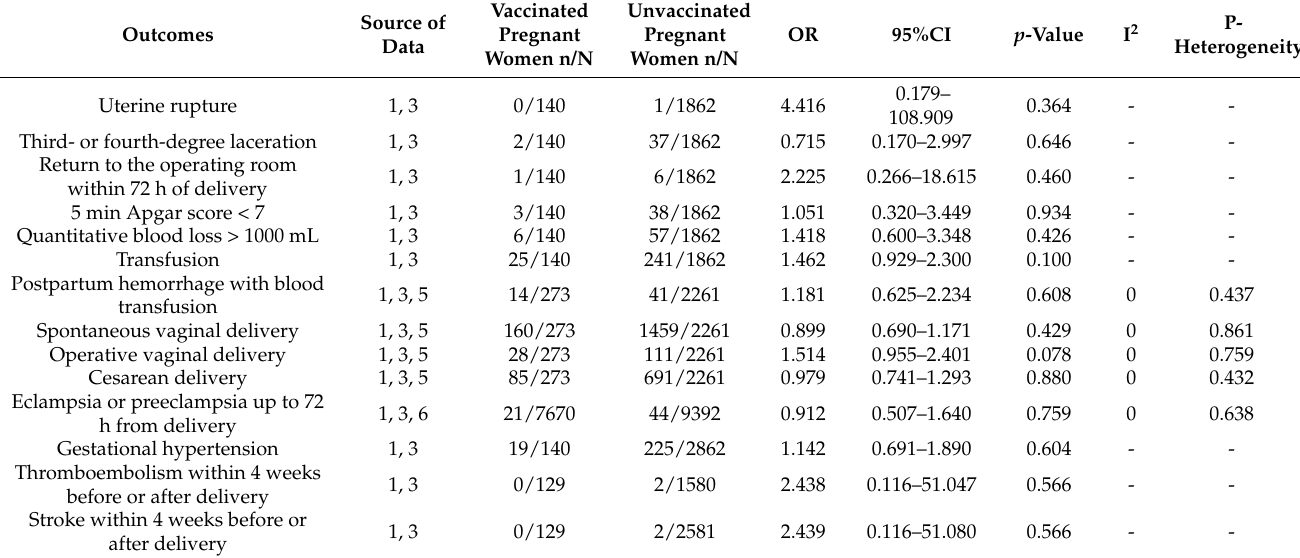
Table 7. Adverse pregnancy outcomes among pregnant women with and without COVID-19 vaccination.